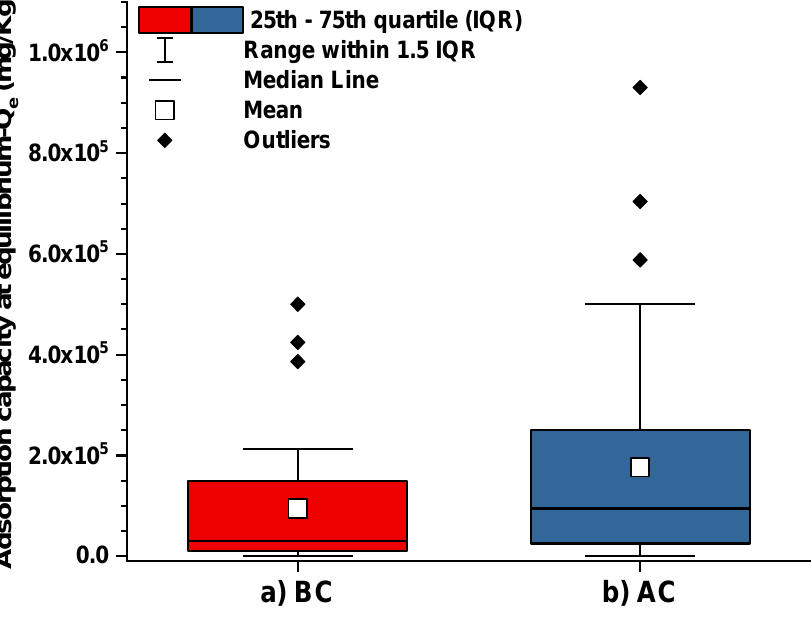
Figure 1. Boxplot of adsorption capacities at equilibrium for BCs ( a ) and ACs ( b ). n = 50 for both series. Inter quartile range (IQR), median, means, and ranges were calculated through OriginLab software. Ranges were calculated as 1.5-fold the IQR, according to Apton and Cook [165]. Graphical results demonstrate that the inter quartile range (IQR-green box), which is between 25th (Q1) and 75th quartile (Q3), obtained for the q e values of ACs is wider than the one obtained for BCs. Indeed, for BCs, the Q1 and Q3 values are 10,000 mg/kg and 150,000 mg/kg, respectively, with an IQR area (Q3-Q1) of 140,000 mg/kg, while for ACs, the Q1 and Q3 values are 21,400 mg/kg and 266,400 mg/kg, respectively, with an IQR area